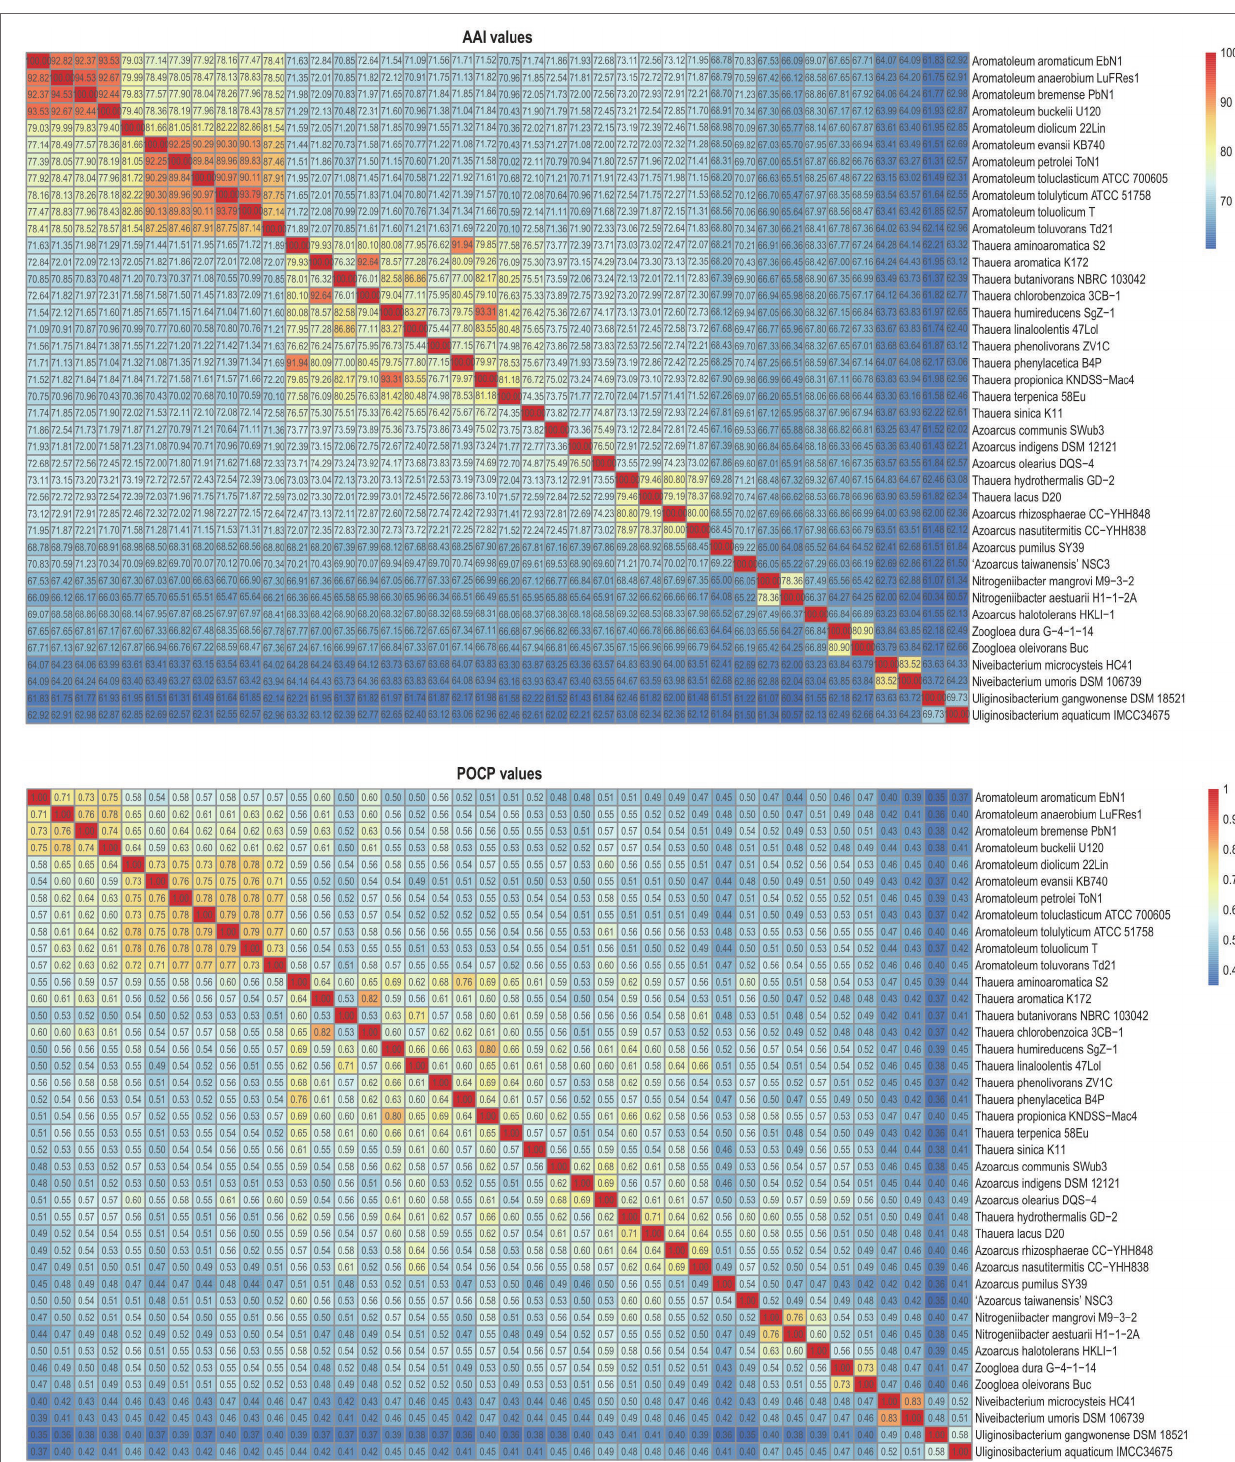
FIGURE 4 | Heatmap showing the AAI values (upper panel) and POCP values (lower panel) among the members of the family Zoogloeaceae